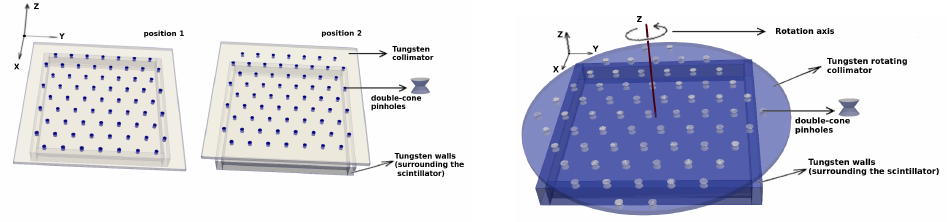
Figure 2. Different detector configurations: a mobile collimator with linear motion and two positions ( left ); and a circular collimator and its corresponding rotation axis ( right ). The coordinate system employed in both cases is also